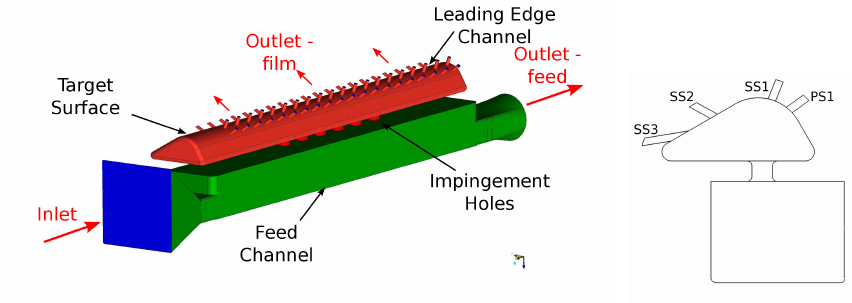
Figure 3. Test section geometry and cross section.